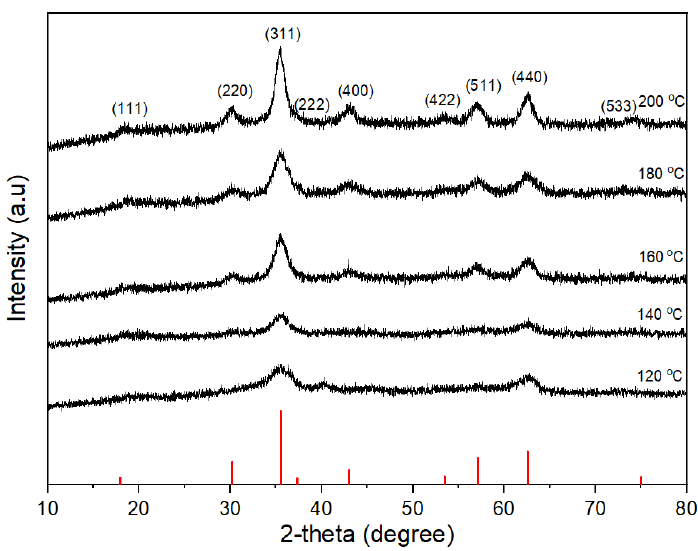
Figure 5. XRD patterns of CoFe 2 O 4 nanoparticles synthesized at 16 h in the presence of 1 M oleic acid for different reaction temperatures.